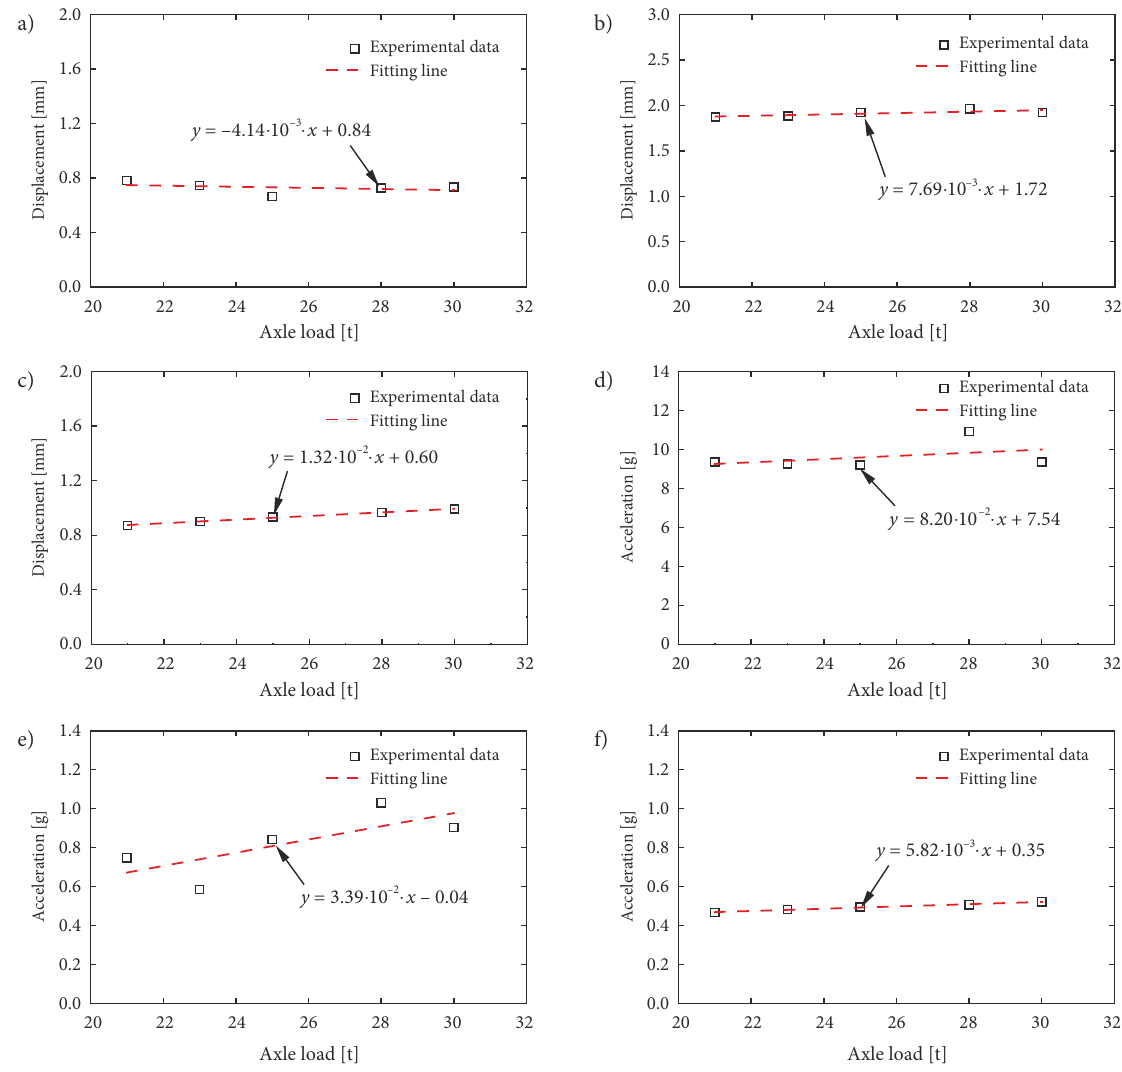
Figure 13. Statistical results as increase of train running speed: a – rail lateral displacement; b – rail vertical displacement; c – sleeper vertical displacement; d – rail vertical acceleration; e – sleeper vertical acceleration; f – ballast bed vertical acceleration variation with increasing axle